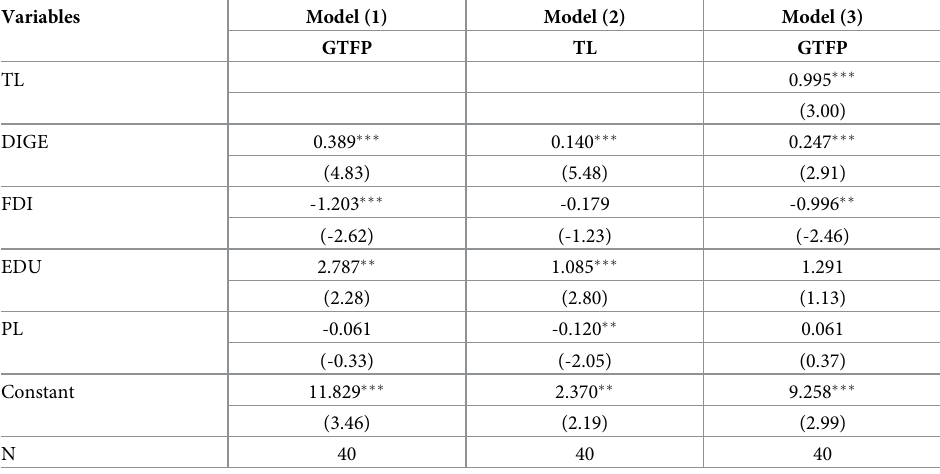
Table 10. Evaluation of the mediation effect of industrial structure